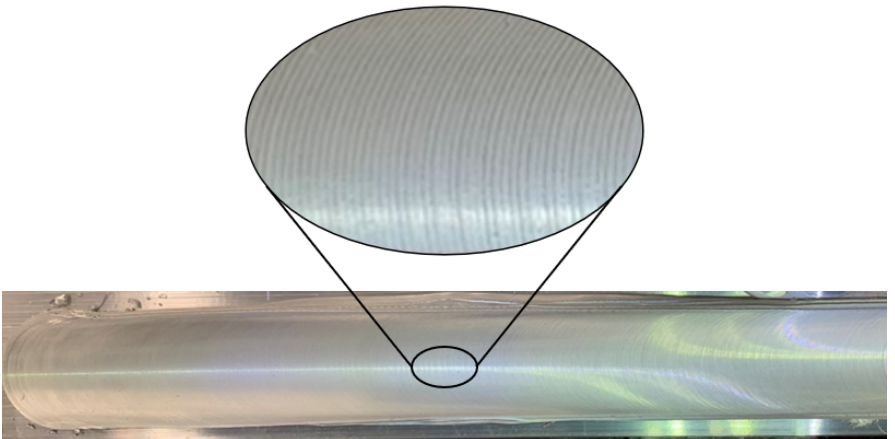
Figure 7. The resulting weld from Protocol G (i.e., combined temperature and force control). No galling or beading was